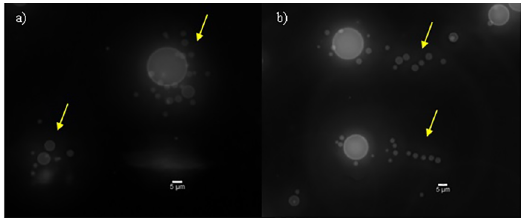
Figure 4. Optical fluorescence microscopy images of GUVs comprised of DLPC and 0.5 % of rhodamine after successive additions of 1 M